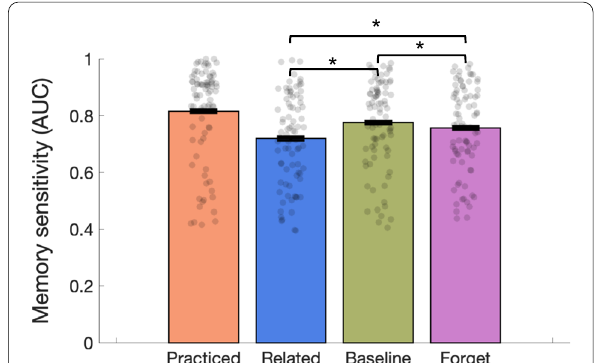
Fig. 4 Experiment 2 Results, showing only the subjects who reported they did not believe that Forget items would ever be tested (N Replicating Experiment 1, directed forgetting